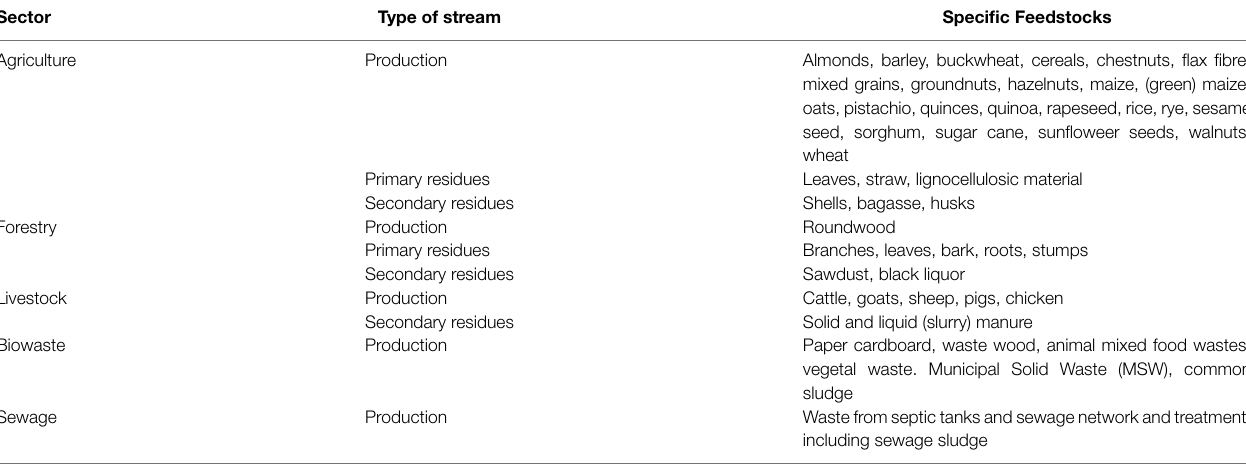
TABLE 1 | Specific feedstocks considered, the production stream they fall into and the respective sector. For agriculture, forestry and livestock, only the primary and secondary residues of the product are considered as feedstocks.